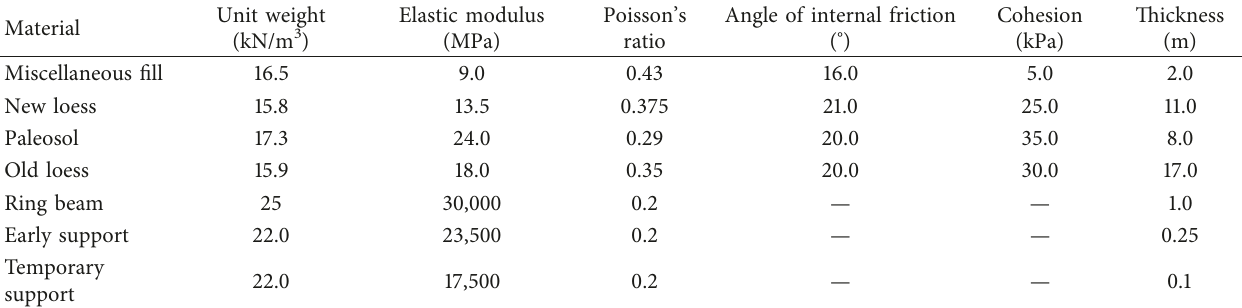
Table 3: Physical and mechanical parameters of